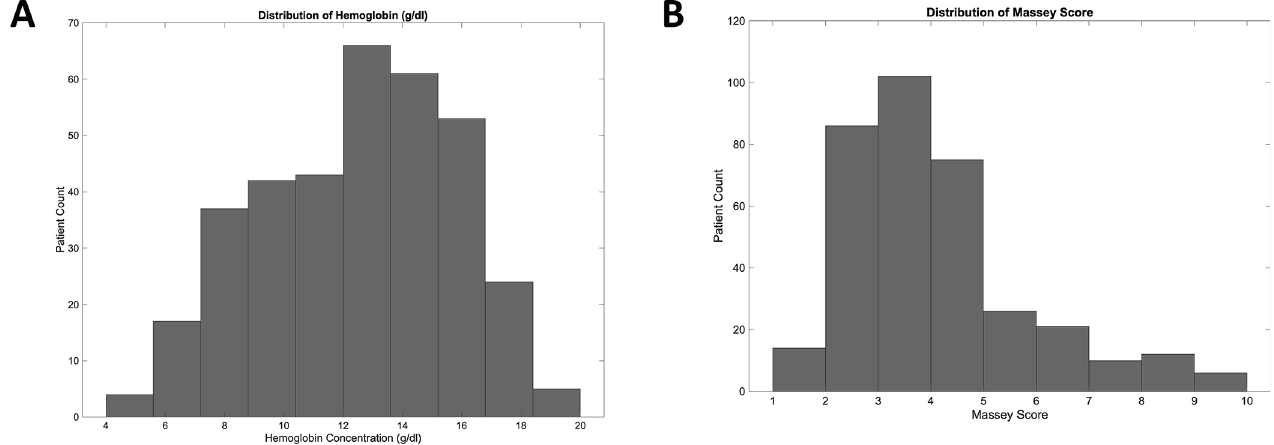
Fig 2. Distribution of hemoglobin values and skin tones scored across 344 imaged ED patients. ( A) Laboratory assayed hemoglobin concentration was distributed into 2 g/dL bins from 4 g/dL to 20 g/dL. (B) The Massey Score distributed into 9 bins from 1 to 9. Lower Massey scores correspond to lighter skin and higher scores darker skin